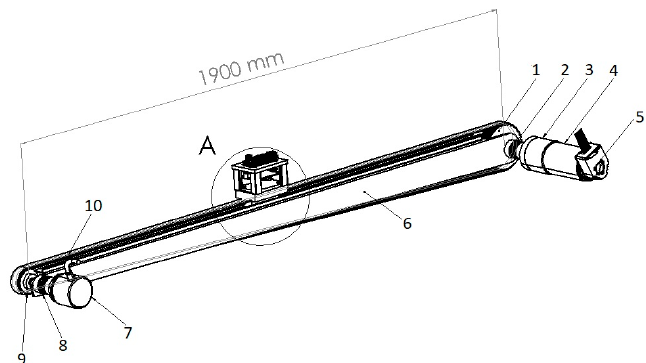
Figure 1. Project of the test stand with linear guide and servo actuator [30].